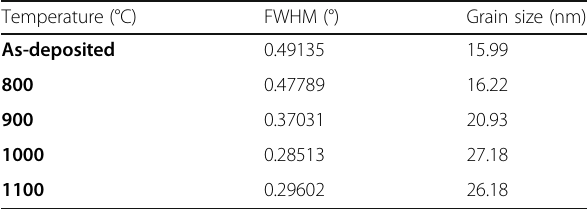
Table 1 The grain size of polycrystalline films at different annealing temperatures